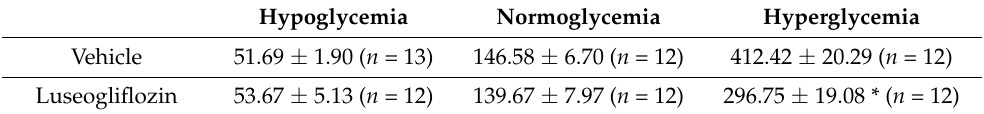
Table 1. Blood glucose levels (mg/dL) before 2-NBDG injection.